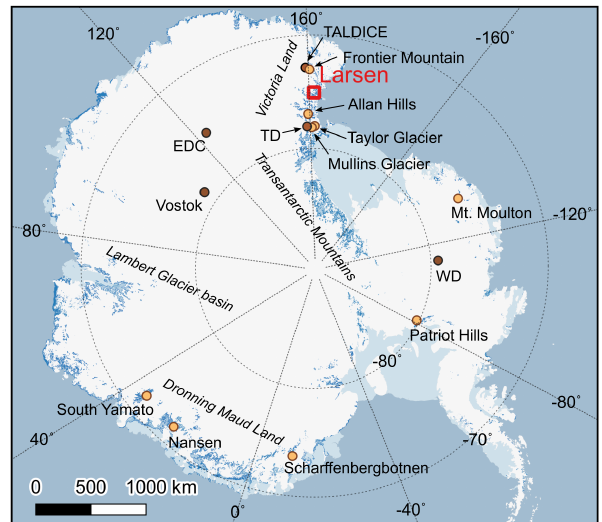
Figure 1. Distribution map of BIAs in Antarctica. BIAs are noted in dark blue (Hui et al., 2014). Orange dots represent the BIAs where the chronology has been studied. Deep-ice-core locations with brown dots are labeled as follows: TALos Dome Ice CorE (TALDICE), Taylor Dome (TD), EPICA (European Project for Ice Coring in Antarctica) Dome C (EDC), West Antarctic Ice Sheet (WAIS) Divide (WD), and Vostok. To keep a consistent orienta- tion with the GPR profile in Fig. 3, we flipped the classical map of Antarctica (East Antarctica to the left-hand side). The Antarctic map was obtained from the QGIS (geographic information system) Quantarctica